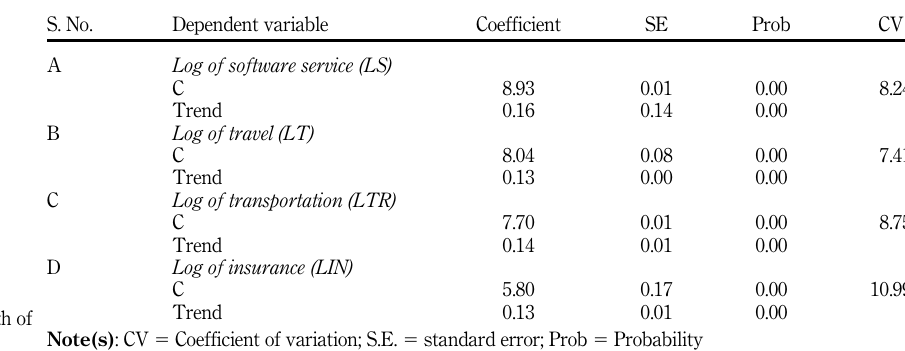
Table 8. Estimates of growth of software